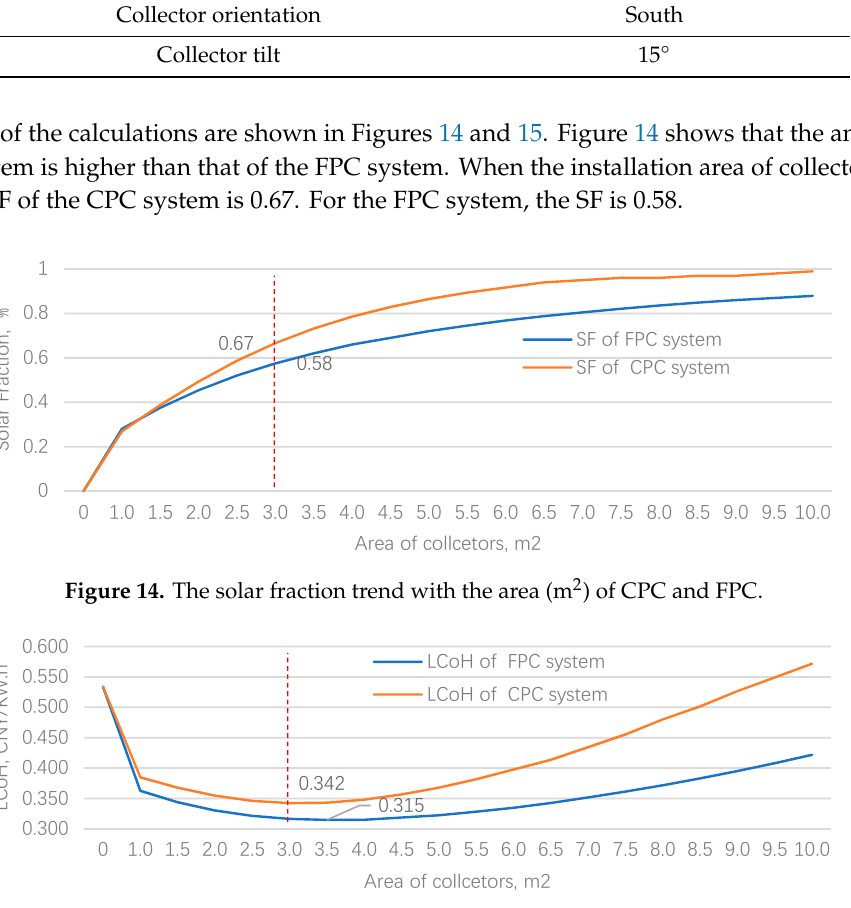
Figure 16. The LCoH curves with the area (m 2 ) of collectors with different auxiliary heat sources. 5.2. Limitations of this Study and Future Work This study is based on the technical and economic analysis of China's experience in the application of SWH systems in high-rise buildings. Due to limited time and resources, it is impossible to investigate all SWH systems in high-rise buildings in China, which limits the geographic coverage of the study. The collectors are limited to the types that have also been widely used. It can be seen from the comparison of various familiar collectors in Table 3 that the listed solar collectors are difficult to integrate with architectural design, due to their large size, considerable weight, and single color (usually black or blue). These factors affect the widespread use of solar heat in high-rise buildings. With the rise of building integrated photovoltaic (BIPV) [66 – 68] and air source heat pumps in recent years, the application of SWH systems in urban buildings is facing increasing challenges. However, with technological innovation, there will be more collectors that can easily be integrated into building facades [69], e.g., a PV/T collector that can generate heat and electricity [57], solar thermal air collectors, ceramic solar collectors, polymer solar collectors and solar louvre collectors that can be integrated into curtain walls.